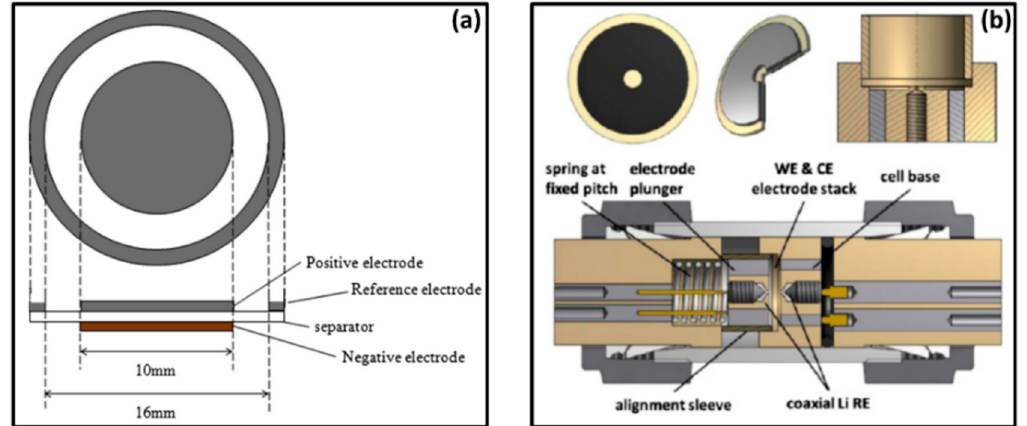
Figure 16. Coaxial ( a ) and reversed coaxial ( b ) cell configurations. Reproduced with permission from [87,115].